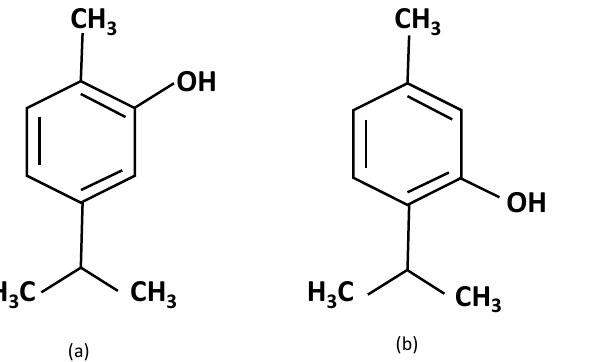
Figure 1. Structure of thymol and carvacrol present in thyme essential oil. ( a ) Carvacol; ( b ) thymol.